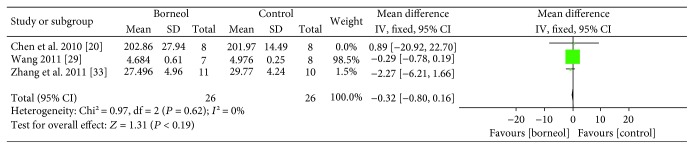
The forest plots: the borneol group versus the control group on MDA level under pathological conditions.